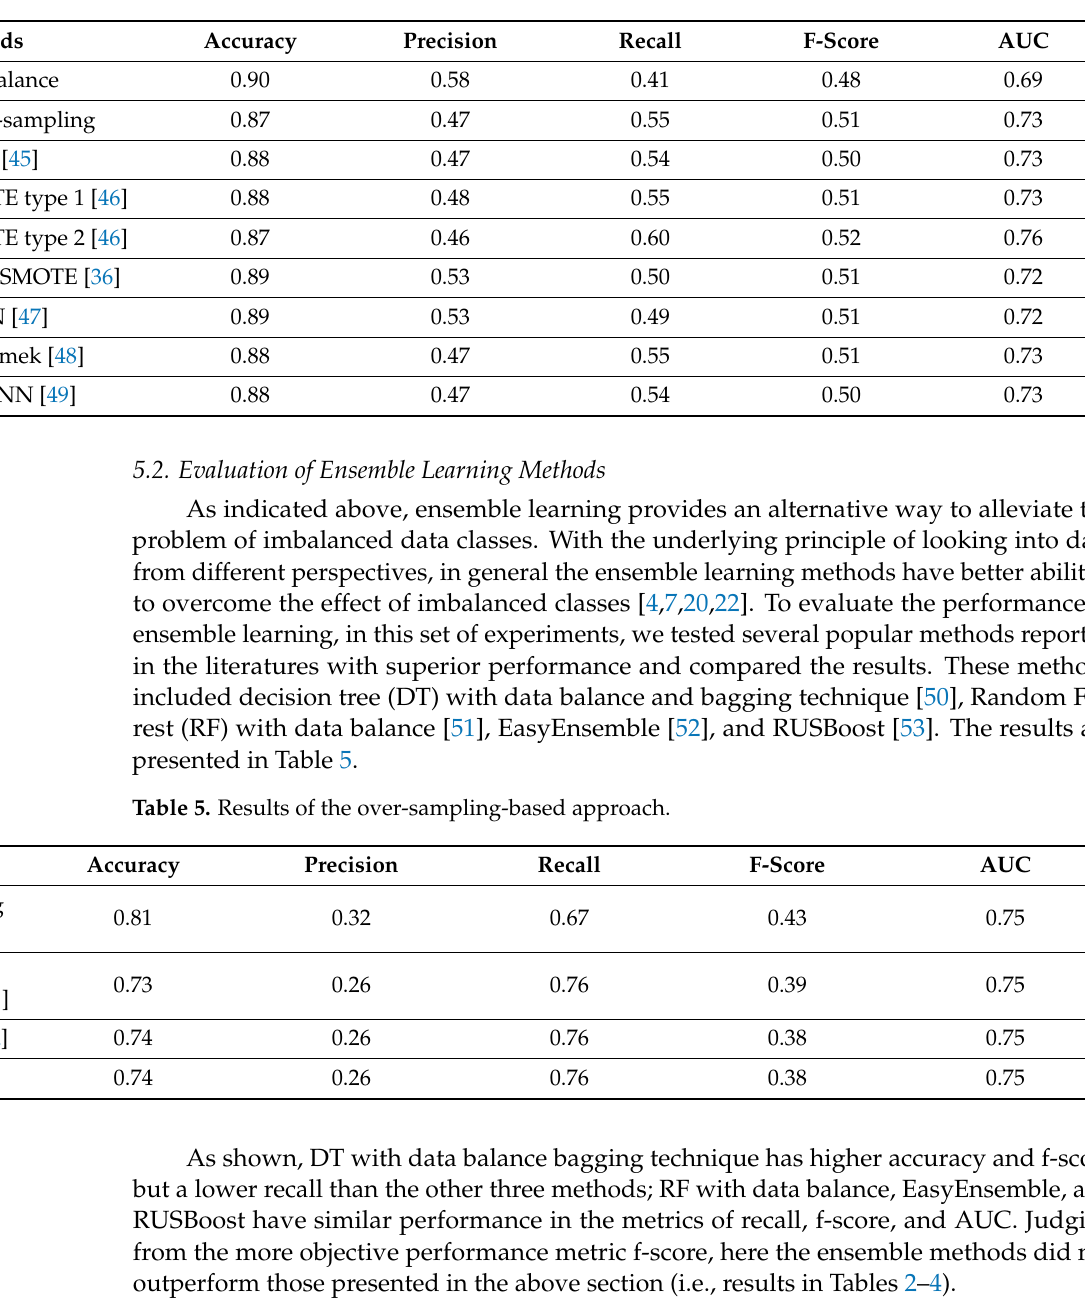
Table 4. Results of different methods with an over-sampling-based method.